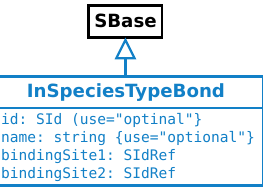
Figure 7: The definition of the InSpeciesTypeBond